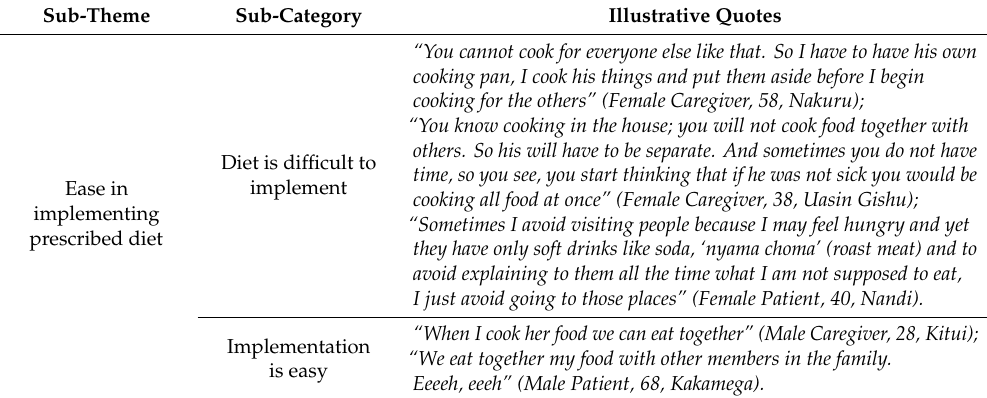
Table 2. Sub-theme 2—illustrative quotes on “ease in implementing prescribed diet”.